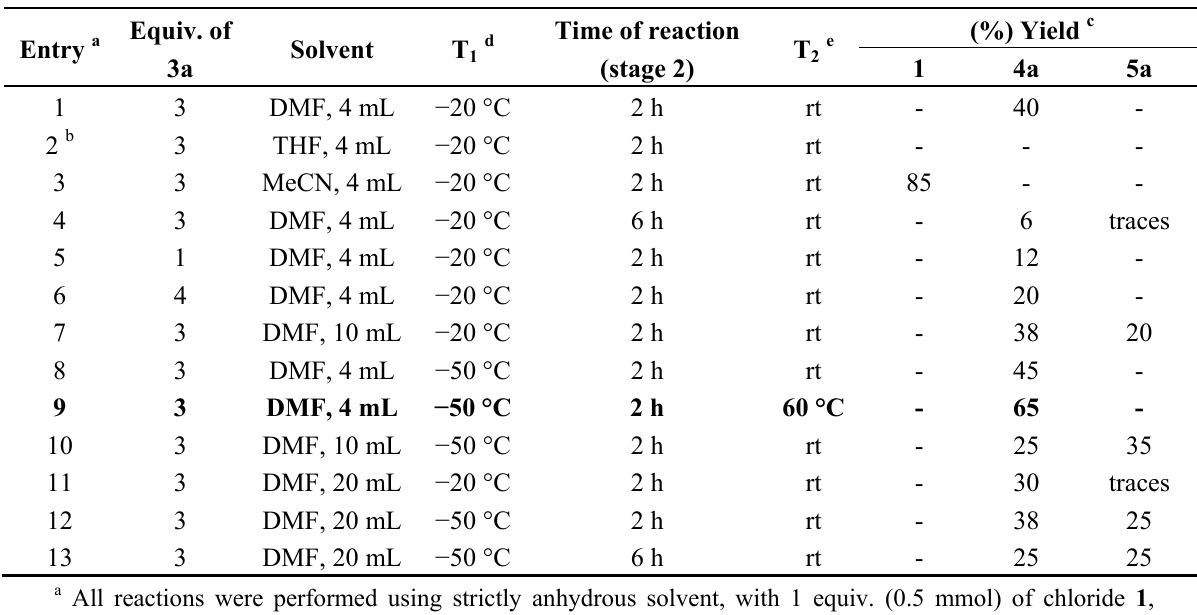
Table 1. Reactivity of 1-(3-chloroprop-1-ynyl)-4-nitrobenzene 1 with p -chlorobenzaldehyde 3a . Entry